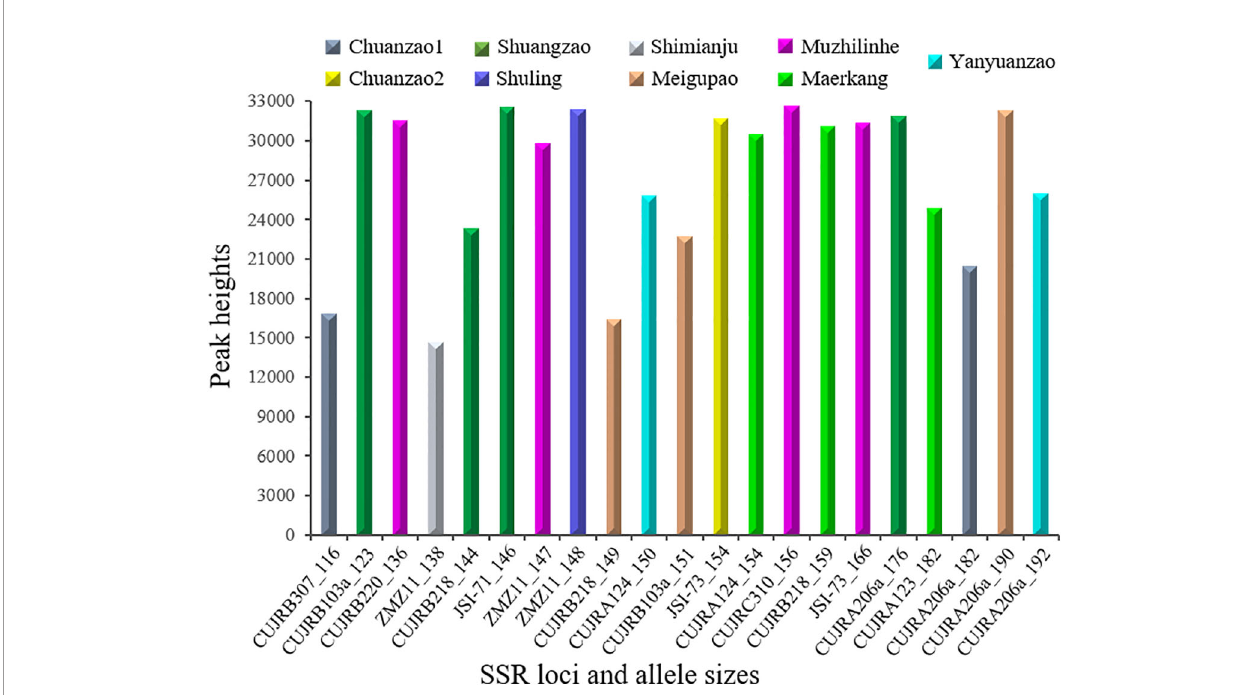
FIGURE 8 | Nine cultivars were discerned by 21 selected SSR allele sizes. The x-axis indicates SSR locus and allele size, while the y-axis indicates relative peak height. The allele size ranged from 116 to 192 nucleotides, while the relative peak height ranged from 14,643 to 32,607. The Chuanzao 1 cultivar was discerned by CUJRB307 (116) or CUJRA206a (182); Chuanzao 2 was discerned by JSI-73 (154); Shuangzao was discerned by CUJRB103a (123), CUJRB218 (144), JSI-71 (146), or CUJRA206a (176); Shimianju was discerned by ZMZ11 (138); Meigupao was discerned by CUJRB218 (149), CUJRB103a (151), or CUJRA206a (190); Muzhilinhe was discerned by CUJRB220 (136), ZMZ11 (147), CUJRC310 (156), or JSI-73 (166); Maerkang was discerned by CUJRA124 (154), CUJRB218 (159), or CUJRA123 (182); Yanyuanzao was discerned by CUJRA124 (150) or CUJRA206a (192); and Shuling was discerned by the combination of ZMZ11 (148) and other SSR loci, which distinguished and excluded Chuanzao 1 [CUJRB307 (116) or CUJRA206a (182)] and Yanyuanzao [CUJRA124 (150) or CUJRA206a